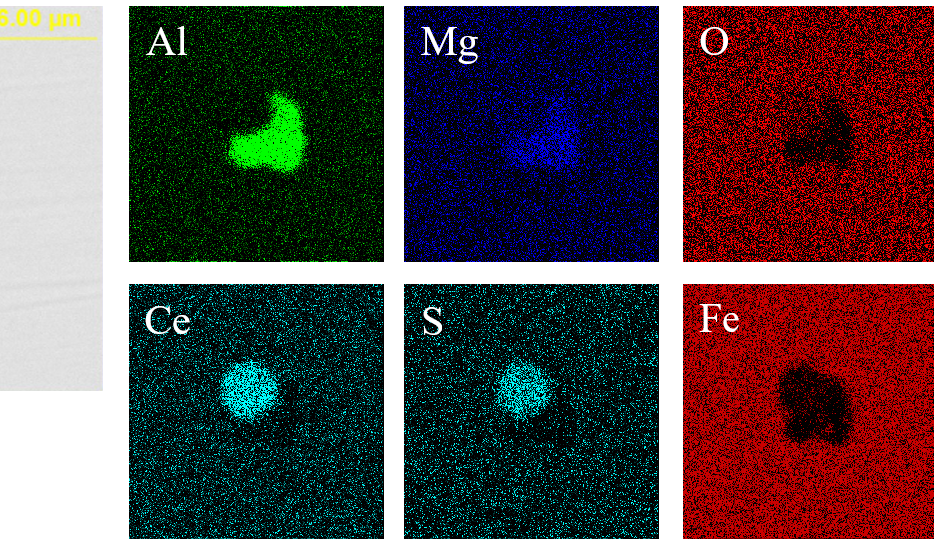
Figure 13. Elemental mapping of a typical inclusion in the steel with 95 ppm Ce content.